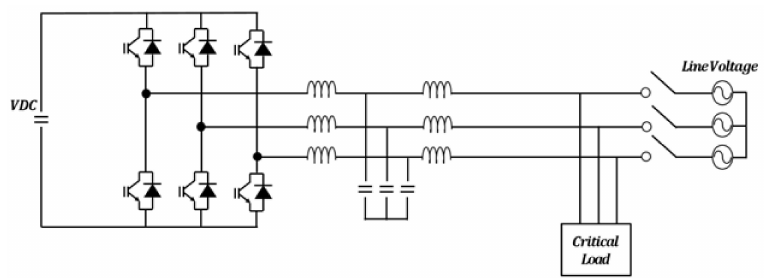
Figure 1. Three-phase microgrid